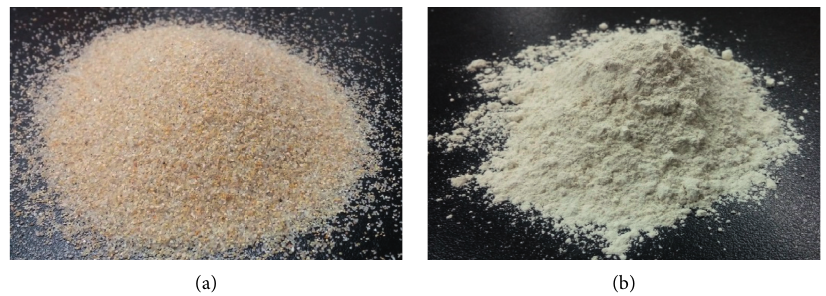
Figure 4: Picture of the tested soil (a) Joomunjin sand (b) Kaolinite.